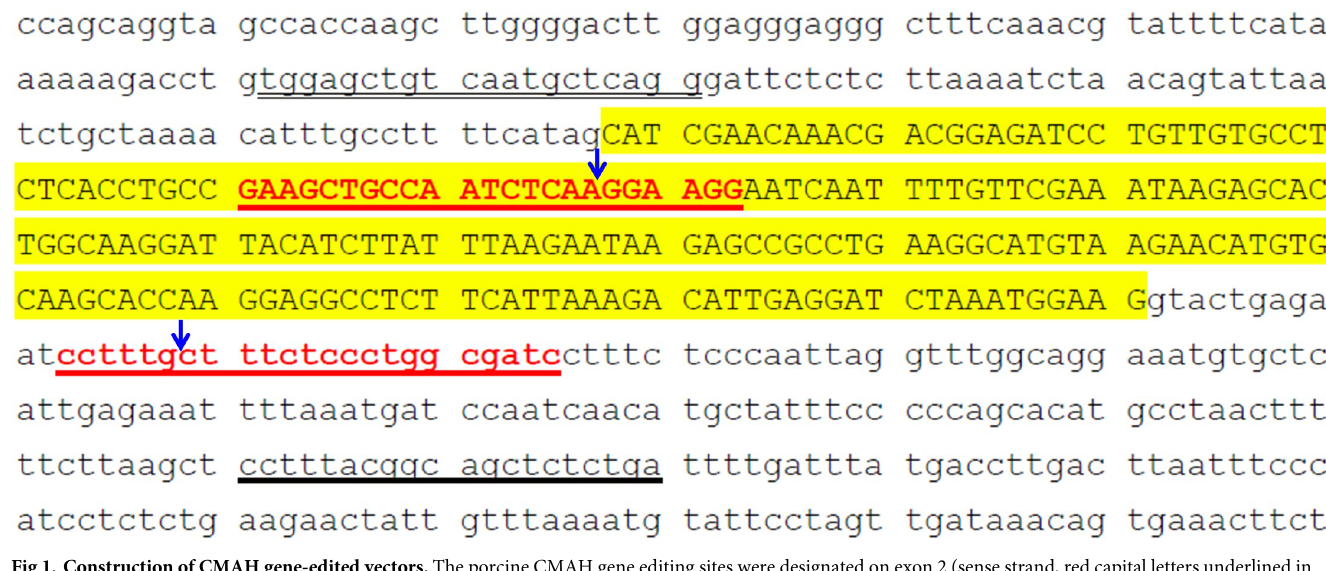
Fig 1. Construction of CMAH gene-edited vectors. The porcine CMAH gene editing sites were designated on exon 2 (sense strand, red capital letters underlined in red) and intron 2 (antisense strand, red letters underlined in red). The sequences underlined in black are PCR primers (CMAH Ex2 F and CMAH Ex2 R). The sequences shown in large capital letters with yellow shading are exon 2. The blue arrows indicate the gene editing sites.